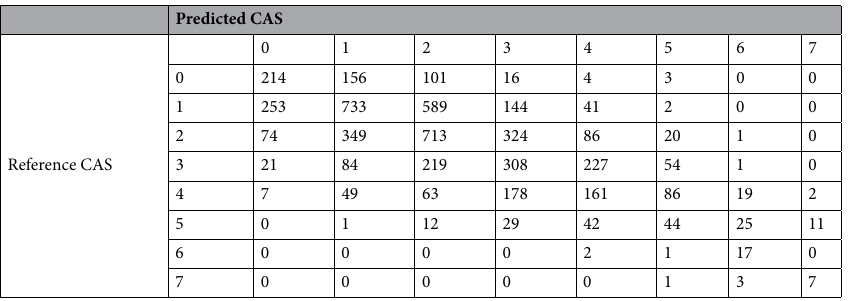
Table 4. Prediction of the CAS by the ML-assisted system using the test set constructed from the entire dataset. All of 5497 test results from 30 repeated experiments were presented. The predicted CAS was generated using the ML-assisted system, and the reference CAS was evaluated by three ophthalmologists using the patients’ facial images. CAS clinical activity score, ML machine learning.